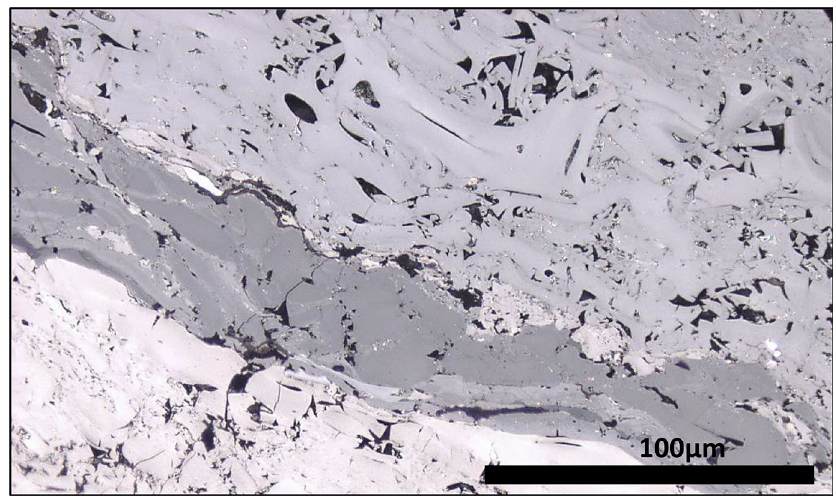
Fig. 8 Inertinite macerals with varying reflectances observed in the inertinite-rich sample. 9 500 magnification, reflected light with oil immersion. Scale is